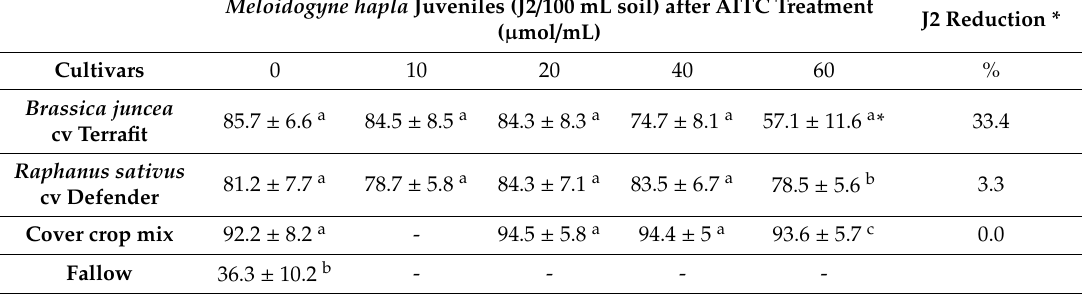
Table 5. E ff ect of allyl isothiocyanate supplementation on the e ffi cacy of the biofumigation potential of three cover crops to control Meloidogyne hapla